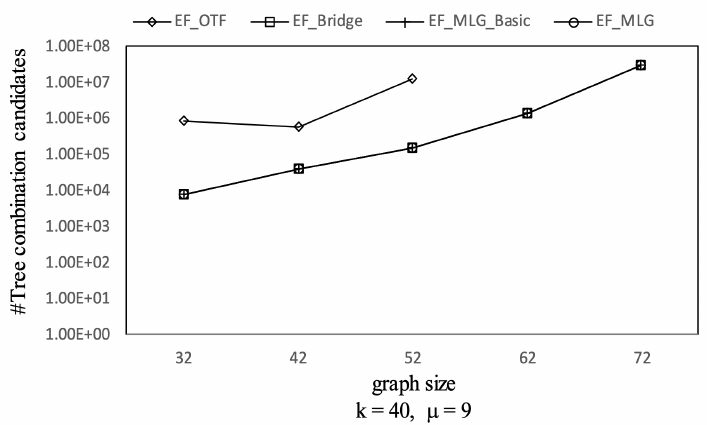
Figure 9. Tree combination pruning on GraphGen vs. graph size with with k = 40 and µ = 9.